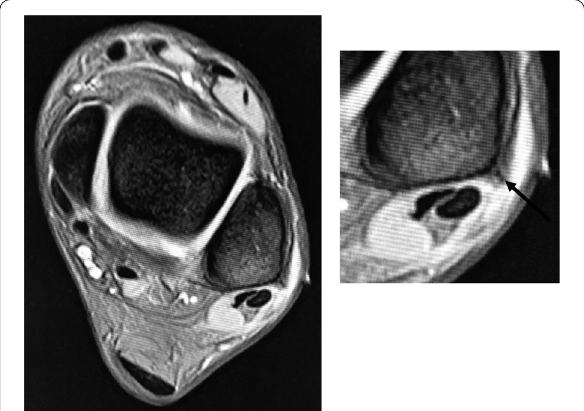
Fig. 1 Preoperative MRI (T2WI). MRI showing a formed false-pouch, although the fibrocartilaginous ridge (arrow) remains